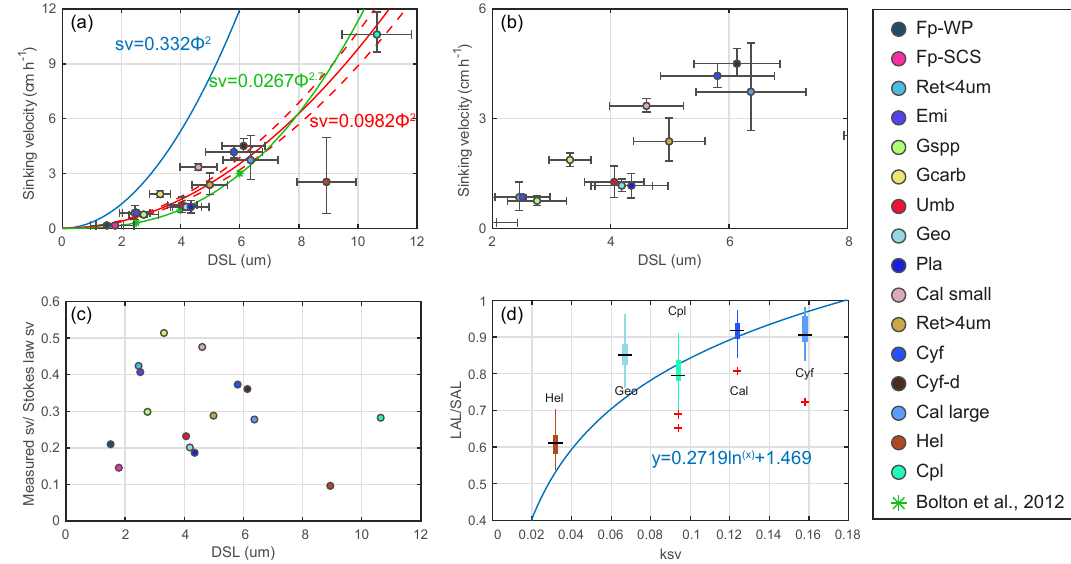
Figure 6. Coccolith sinking velocities and coccolith shape factors. (a–b) Sinking velocities and mean distal shield length. The horizontal error bars represent 1 standard deviation of coccolith length, and the vertical ones represent the 95% confidence level of measured the sinking velocities. The blue, green and red lines represent sinking velocity of calcite sphere objects, coccolith sinking velocities estimated by Bolton et al. (2012) and this study, respectively. (c) The ratio of measured speed and speed calculated by Stokes’ law. (d) Coccolith short axis length (SAL) and long axis length (LAL) ratio against shape–velocity factor k v . Box shows median value and upper/lower quartiles, whiskers show maximum and minimum values; outliers larger than 1.5 of the interquartile range are shown as red crosses. The SAL against LAL plot was shown in Fig. C3. The short names of coccoliths can be found in Table 2.